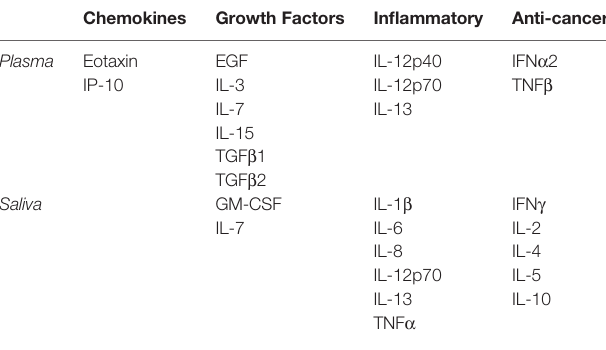
TABLE 1 | Cytokines assessed in blood plasma or saliva of ISS Astronauts.